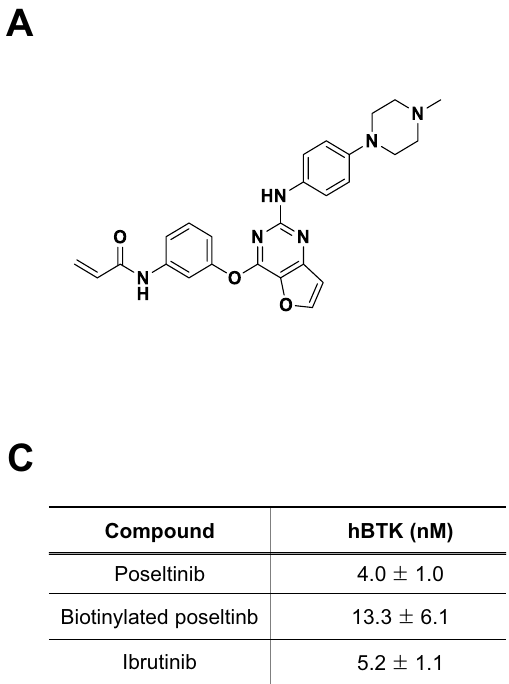
Figure 1. The structure of poseltinib. ( A ) Chemical structure of poseltinib (C 26 H 26 N 6 O 3 as free base; molecular weight, 470.52). ( B ) In silico analysis of binding between poseltinib and BTK (left) and a docking module within the active site of crystallized BTK (right). ( C ) Biochemical assay of the effects of poseltinib and its biotinylated probe on BTK. The data represent the mean ± S.D